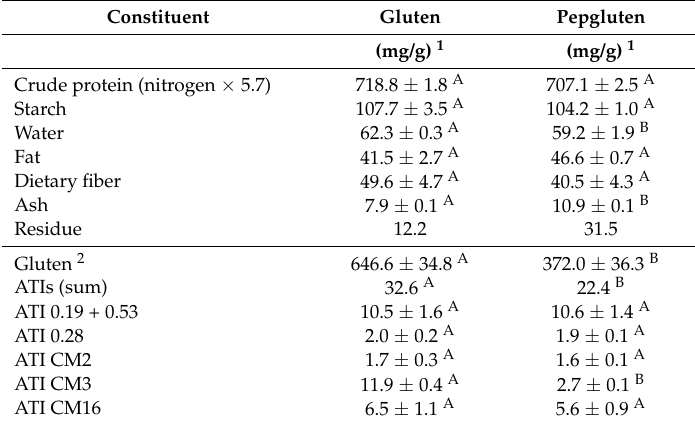
Table 1. Composition of gluten and pepgluten. ATIs: α -amylase/trypsin-inhibitors. Constituent